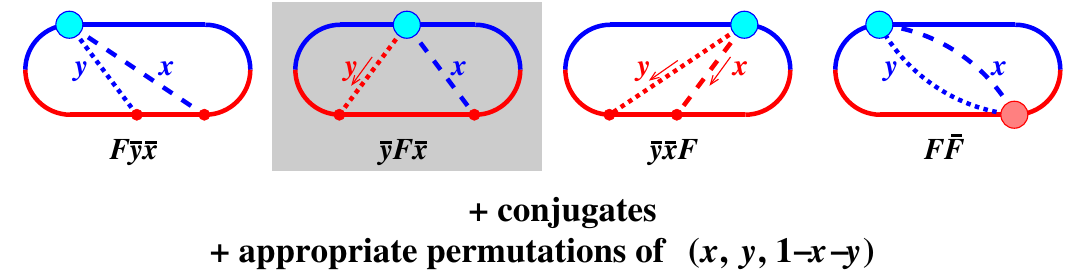
Figure 4 . Diagrams for real double splitting g → ggg that involve an instantaneous exchange or fundamental 4-gluon interaction. See figure 7 for the meaning of the large circular blob. The diagram drawn on a gray background turns out to be exactly zero.